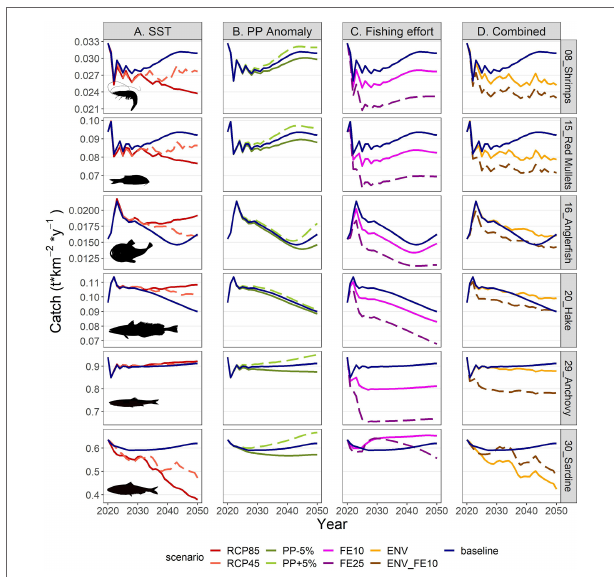
FIGURE 10 | Catch projections for selected FGs in the period 2021-2050 under scenarios related to (A) SST, (B) PP Anomaly, (C) fishing effort and (D) combination of drivers. The description of the scenarios is provided in Table 2.